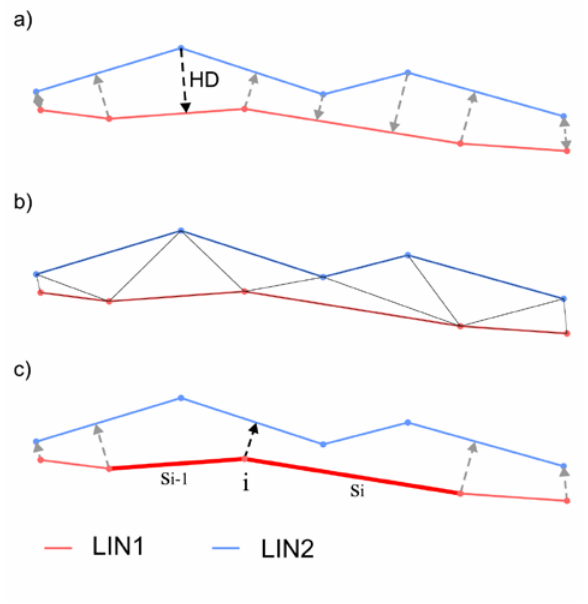
Figure 2. Methods based on lines used in this study Thirdly, the main step of this methodology is related to the control of lines. The two sets of lines are compared using three different methods based on lines both in 2D and 3D in order to analyse the behaviour of height component. The first control method is related to the determination of the Hausdorff Distance (HD) (Abbas et al., 1995) between the homologous lines. The calculation consists of the determination of the maximum distance between the vertexes of the line of LIN1 and the line of LIN2 (Figure 2a) and vice versa. This method provides an estimation of the maximum displacement between the lines. The second is called Mean Displacement (MD). This method was originally described by Skidmore and Turner (1992) for 2D lines and was extended to 3D lines by Mozas and Ariza (2015).